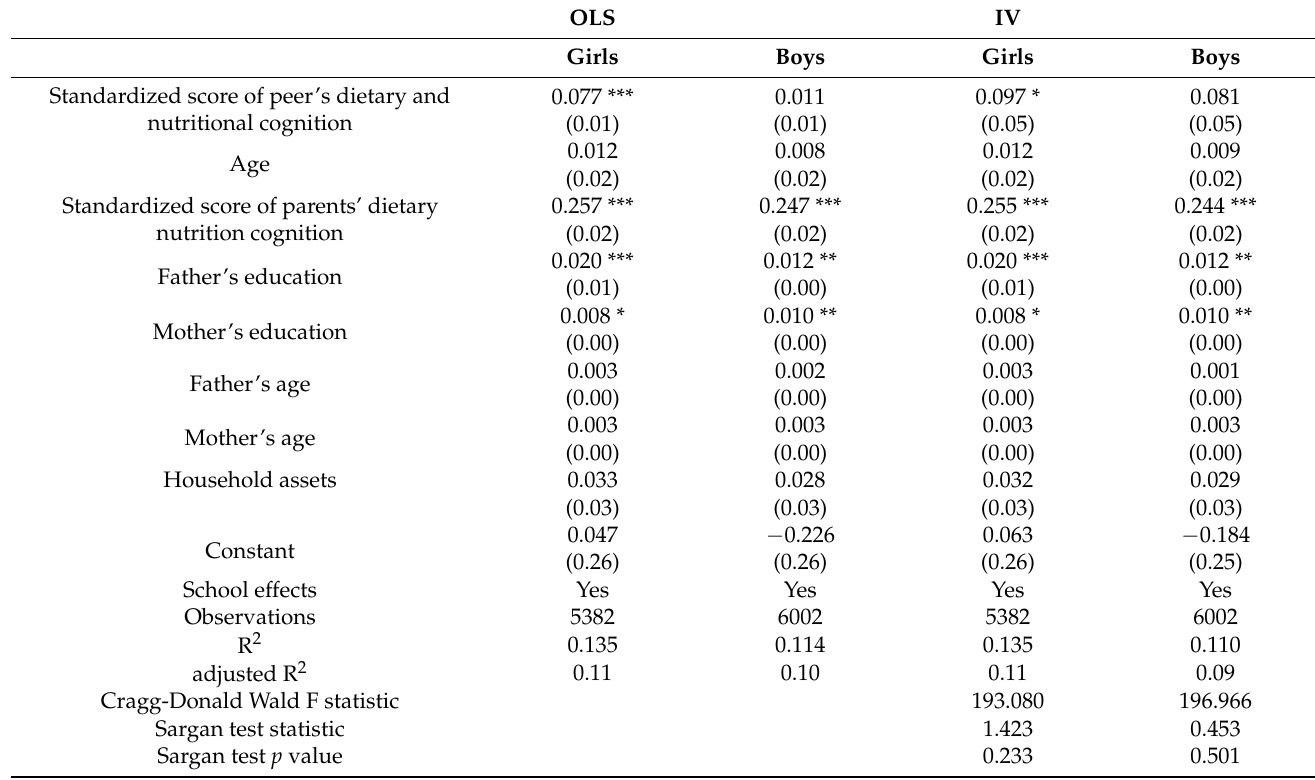
Table 6. Peer effect on the cognition of diet and nutrition for girls and boys. OLS IV Girls Boys Girls Boys